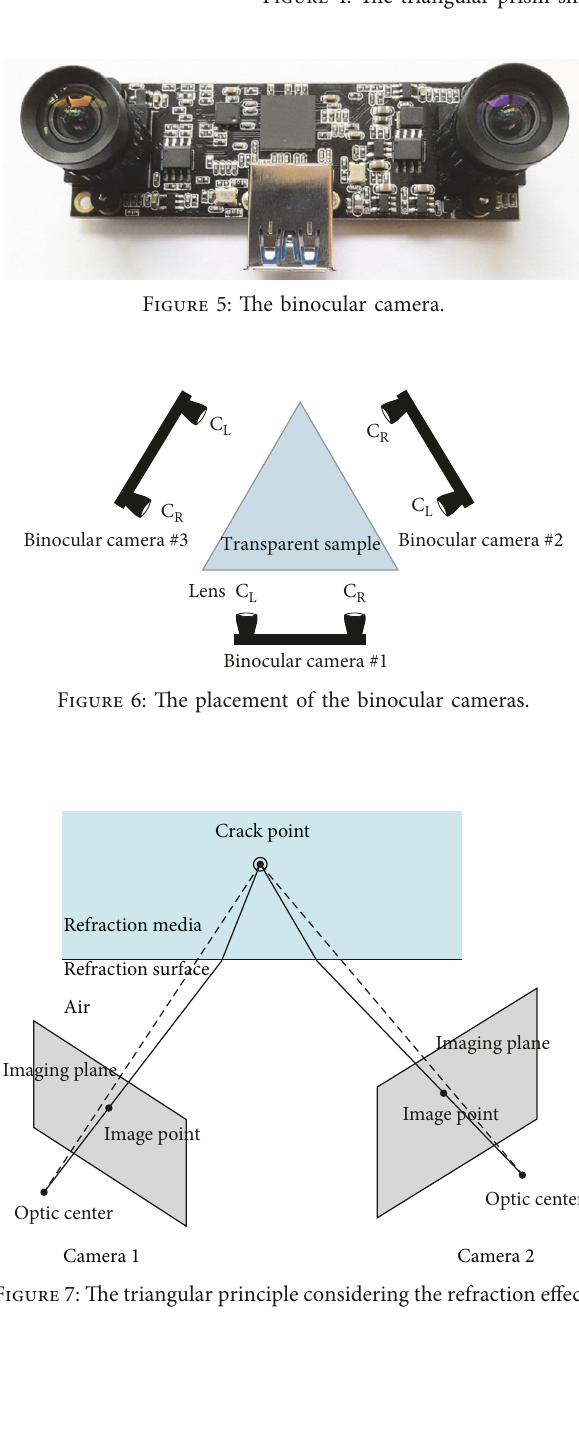
Figure 4: The triangular prism-shaped sample. (a) Top view. (b) Main view.